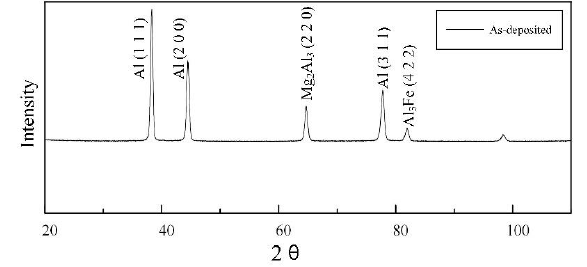
Figure 12. XRD of as-deposited walls.